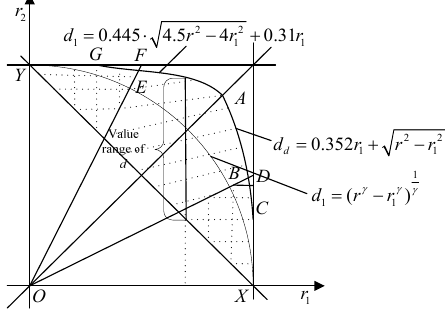
Figure 18. The feasible region of energy-efficiency and interference-optimality in heterogeneous networks.